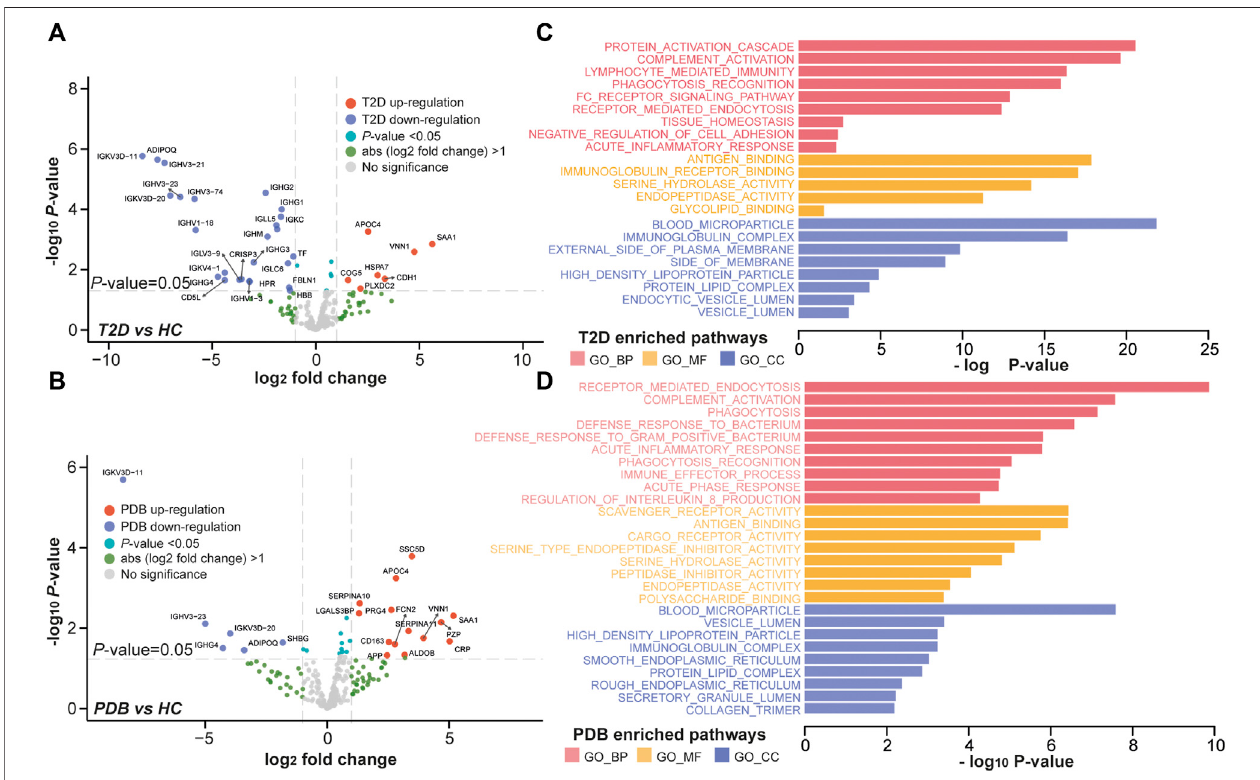
FIGURE 4 | Proteomic alterations in T2D patients and PDB subjects. (A, B) Volcano plots of differential expressed proteins identi fi ed in T2D patients (A) or PDB subjects (B) compared toHC individuals. Red presents upregulationand blue indicates downregulation. Signatureproteins were determined based on a p -value < 0.05 and an absolute log2-fold change ≥ 1. (C, D) GO enrichment results of the signature proteins identi fi ed in T2D (C) and PDB (D) groups.